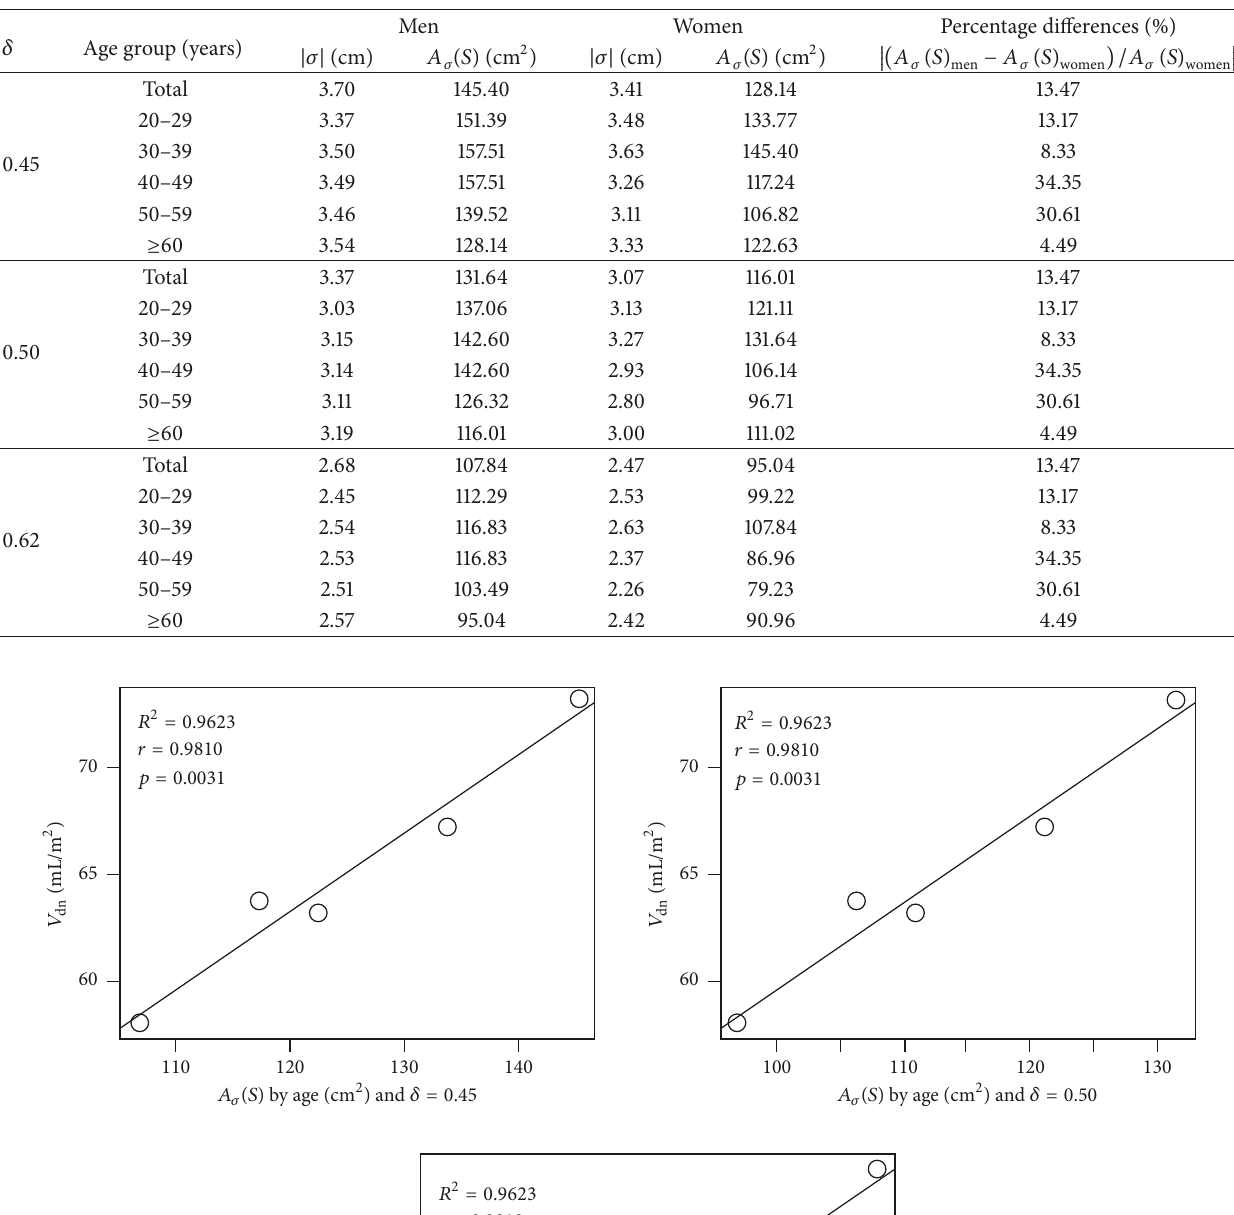
Table 2: Calculated values for |𝜎| and 𝐴 𝜎 (𝑆) parameters, along with the percentage differences, per sex and age group.